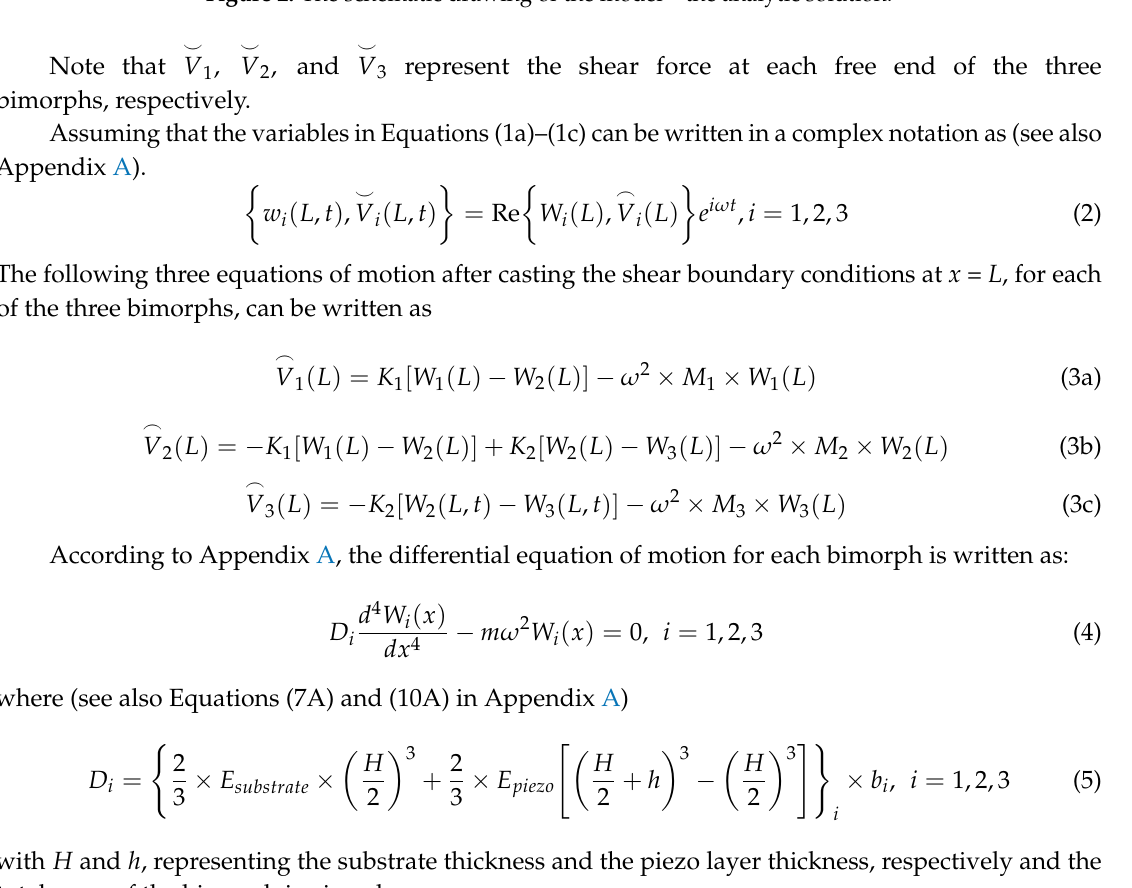
Figure 2. The schematic drawing of the model—the analytic solution.